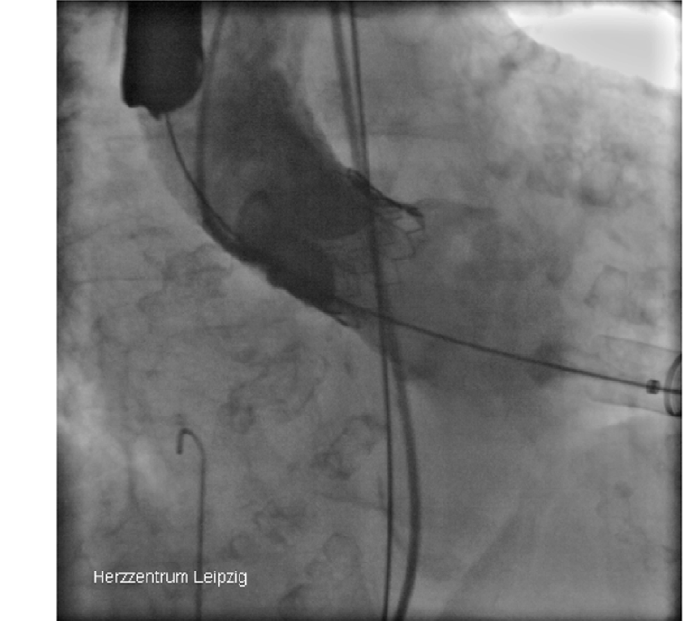
Figure. 2 Main stem occlusion after